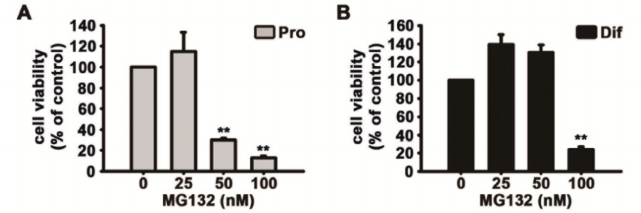
Figure 4. MG132 decreases cell survival during NSC proliferation and di ff erentiation. ( A , B ) Cell viability was assessed using the 3-(4,5-dimethylthiazol-2-yl)-2,5-diphenyltetrazolium bromide assay. NSCs were treated with DMSO or various concentrations of MG132 (25–100 nM) for 2 days ( A ) in the presence or ( B ) absence of EGF and FGF2. Data are presented as mean ± SEM ( n = 3). ** p < 0.01 (Student’s t